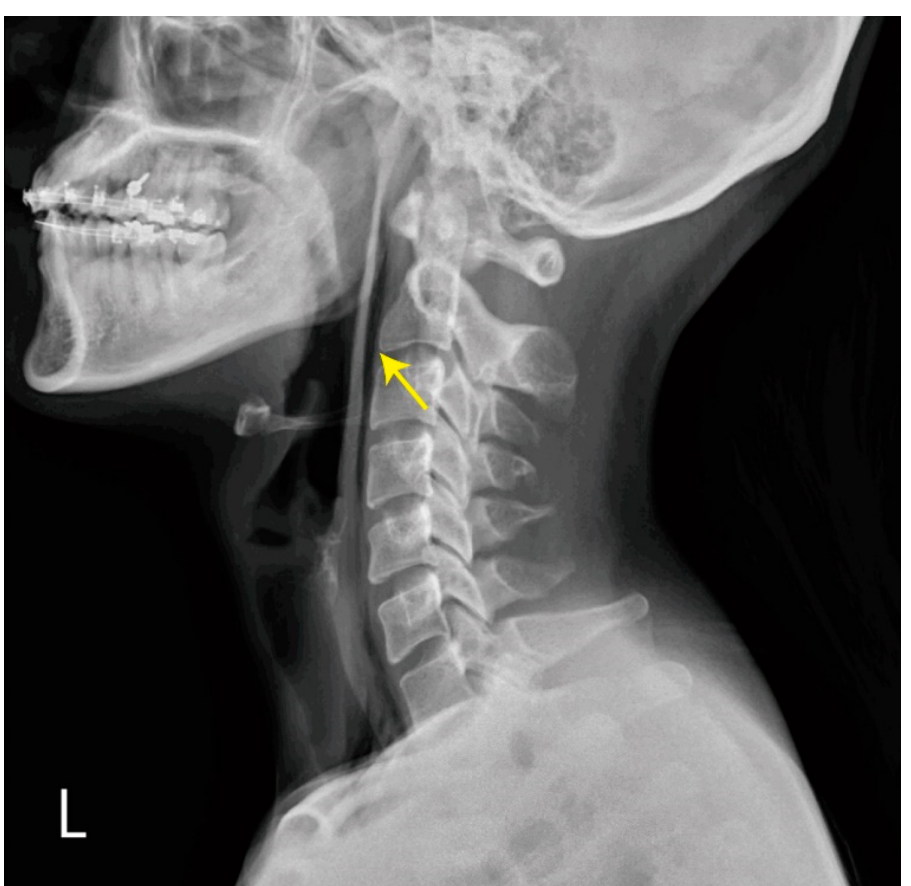
Figure 2. Chest X-ray showed subcutaneous emphysema over the neck and gas outlining from neck extending into the mediastinum (yellow arrow).